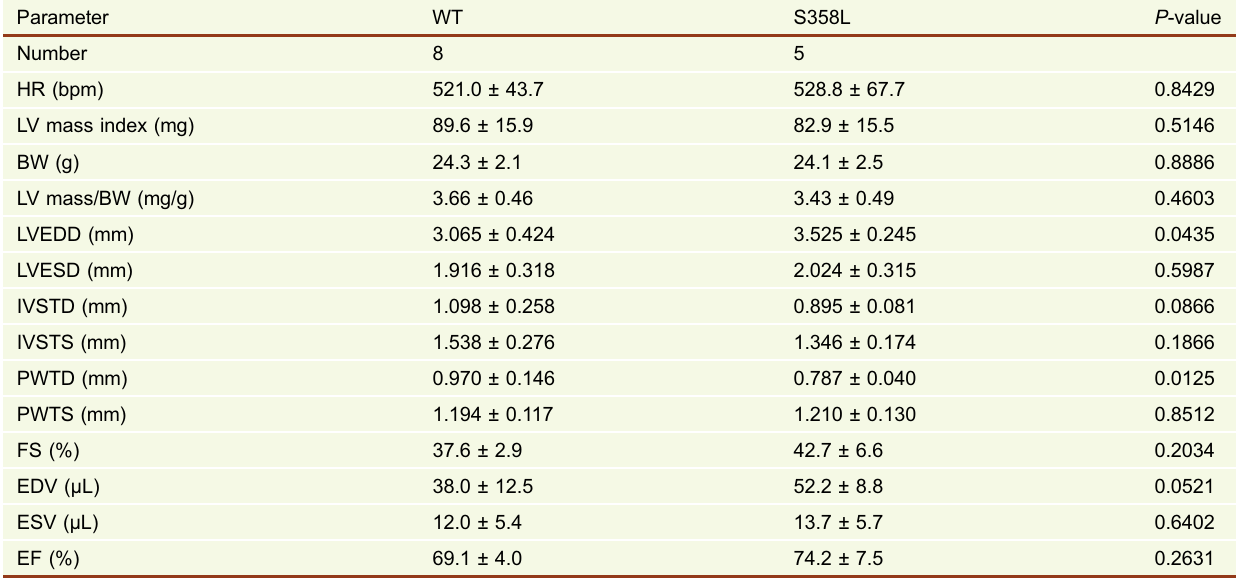
Table 1. Echocardiography of 8-week old male littermate WT and S358L mice